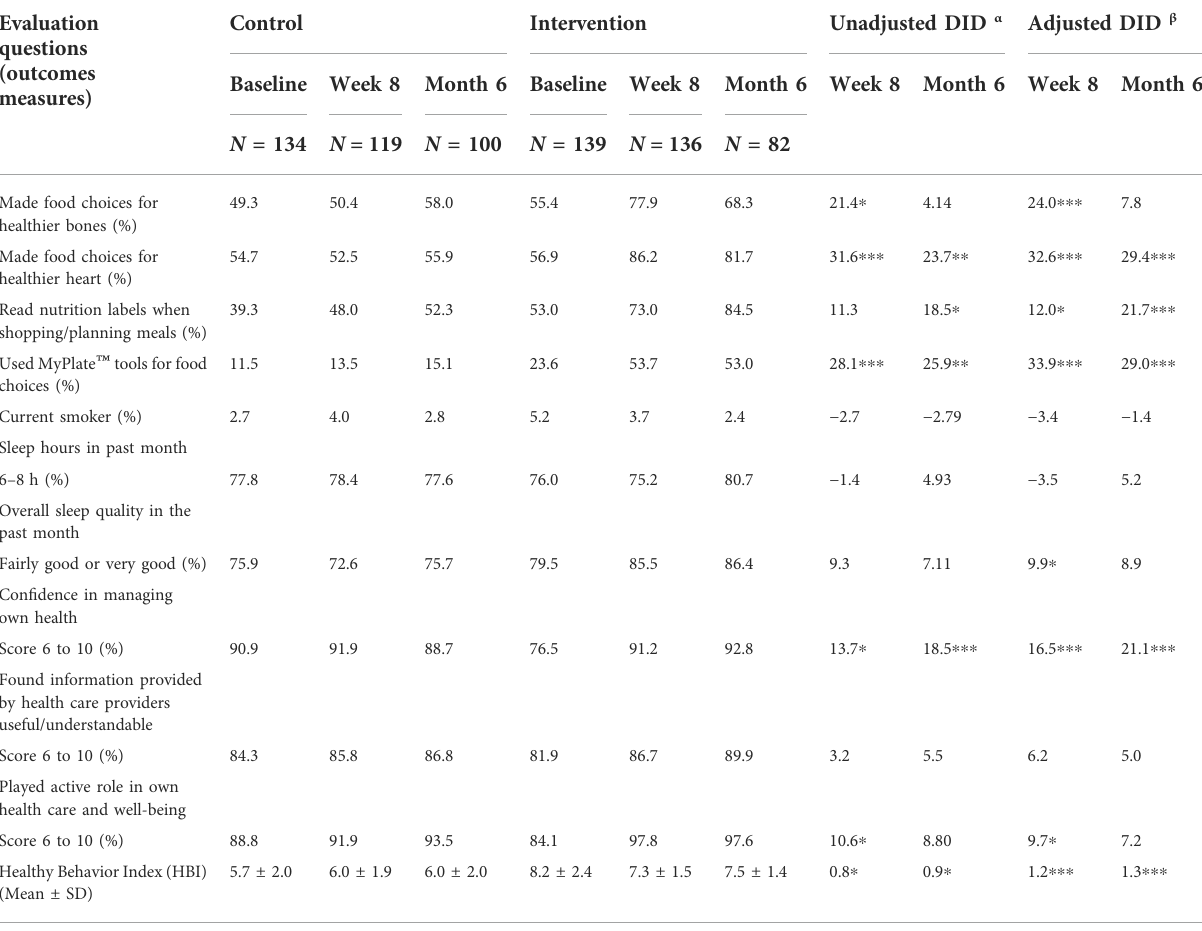
TABLE 4 Intervention impact on lifestyle behaviors (all